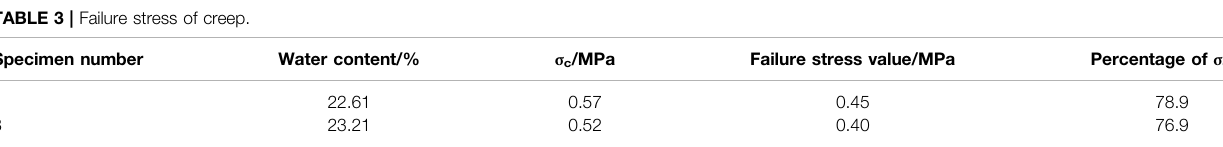
TABLE 3 | Failure stress of